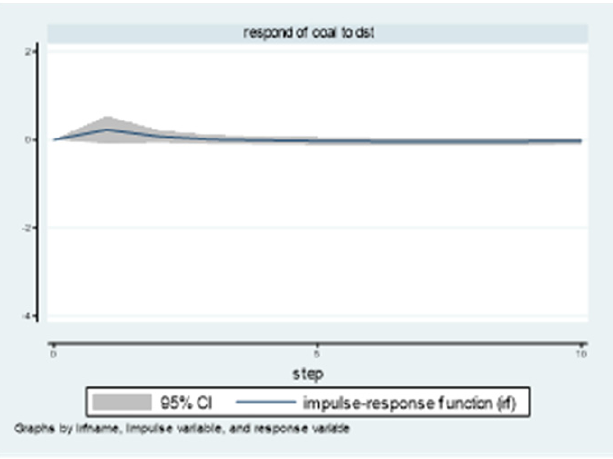
Figure 10. Response of coal consumption rate of fossil power plants.